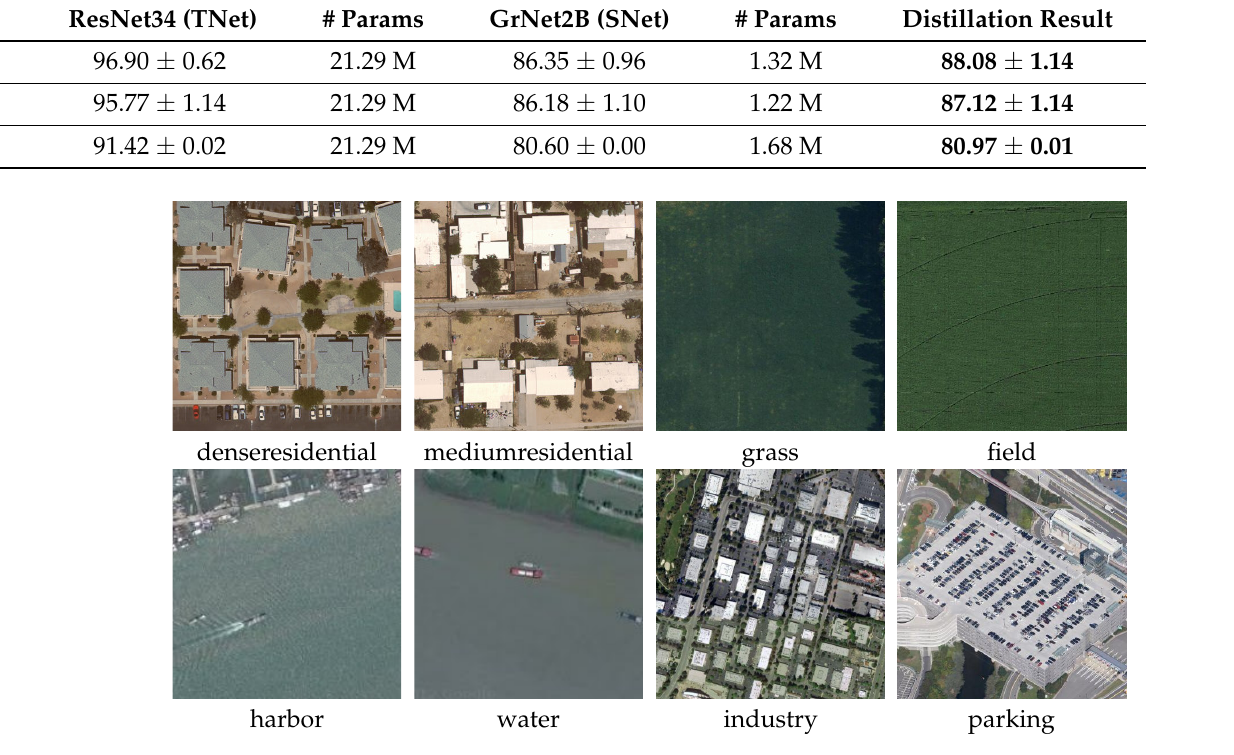
Figure 10. Some examples of misclassified images.They are denseresidential and mediumresidential, grass and field, harbor and water, industry and parking